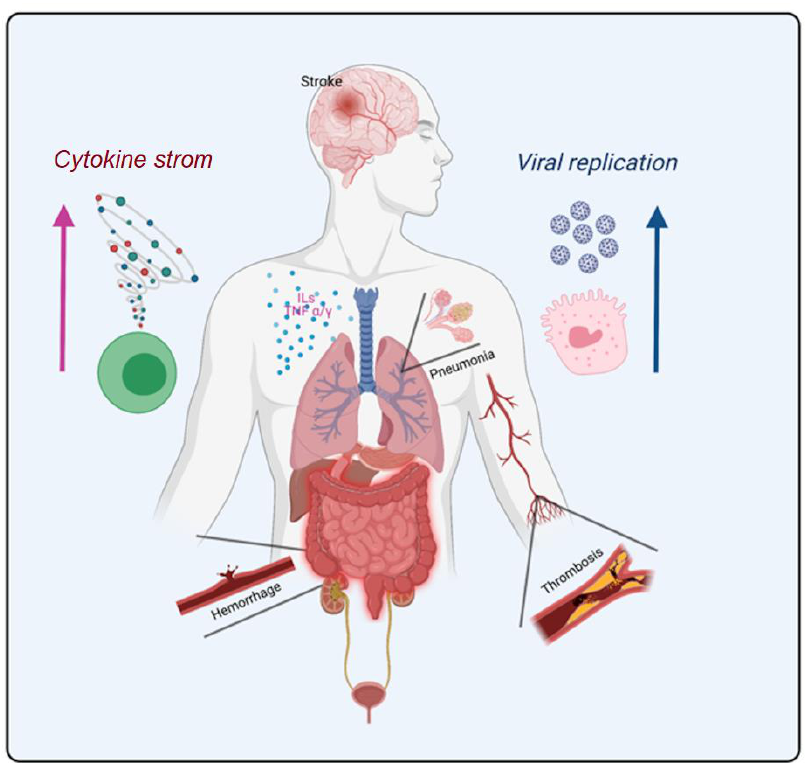
Figure 3. The most relevant human body systems affected by the long-COVID-19 and post-COVID-19 associated symptoms found in articles used in this review.